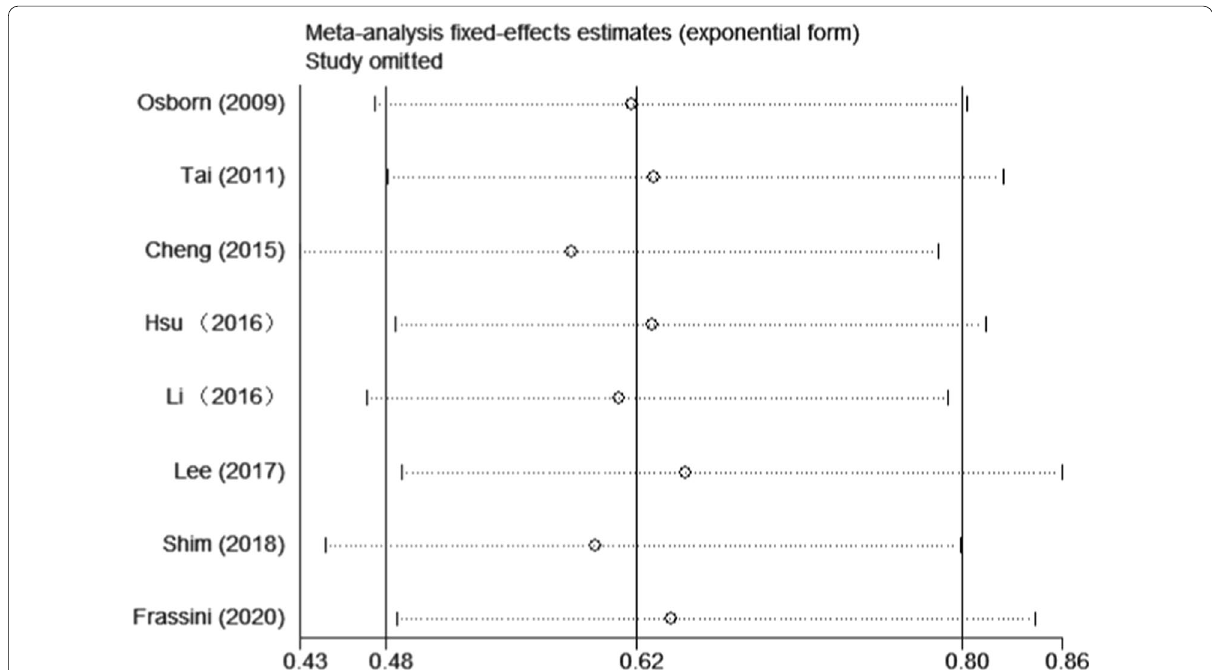
Fig. 4 Sensitivity analysis involving overall mortality, performed by omitting studies one by one. Two studies were omitted just in case of double counting [5, 9]